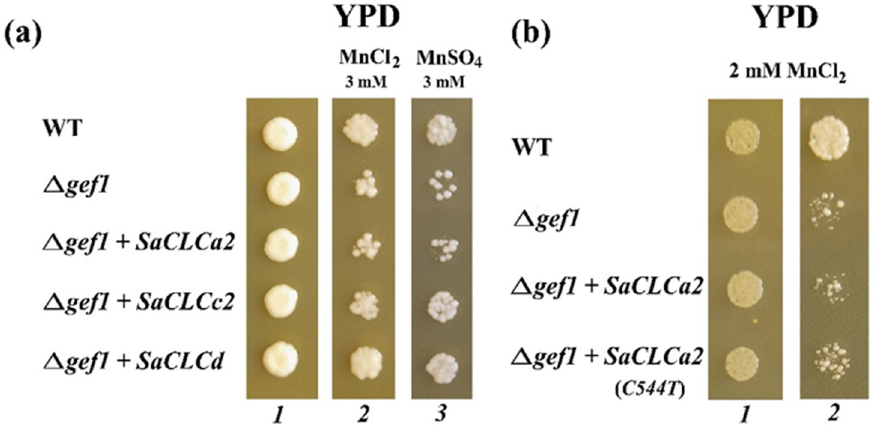
Figure 3. Growth of the yeast mutant ∆ gef1 , transformed with SaCLCa2 , SaCLCc2 and SaCLCd genes. Controls: wild type W3031A and the mutant ∆ gef1 transformed with vector pMB1. Approximately 10 5 cells were placed and grown on selective media. Growth media for ( a ): lane 1—YPD; 2—YPD + 3 mM MnCl 2 ; 3—YPD + 3 mM MnSO 4 ; Growth media for ( b ): 1—YPD; 2—YPD + 2 mM MnCl 2 ; The duration of growth was 3 ( a ) and 2 ( b ) days.